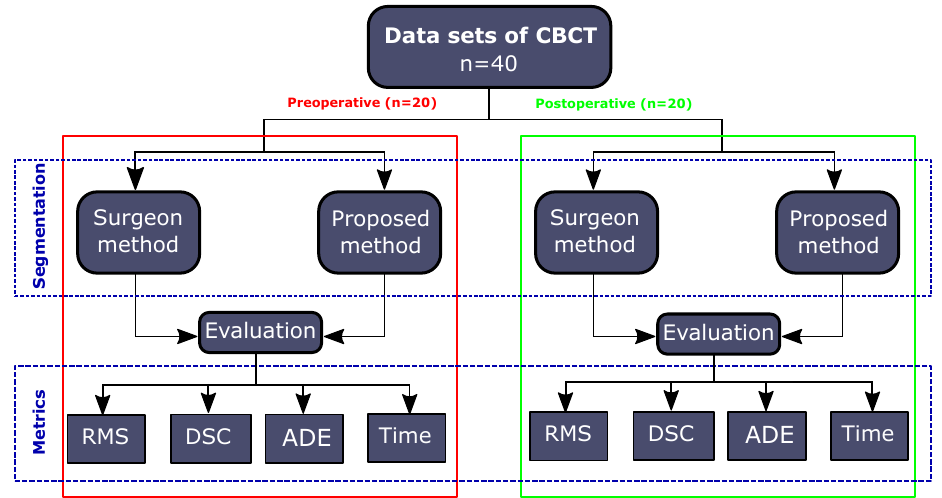
Figure 1. The framework of the current study. The study was performed using preoperative and postoperative Cone Beam Computed Tomography (CBCT) data sets. Four metrics (Root Mean Square (RMS), Dice Similarity Coefficient (DSC), Average Distance Error (ADE) and Time) were used to evaluate the proposed